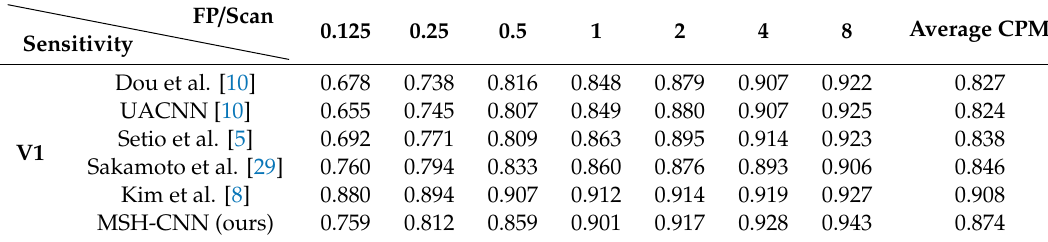
Table 3. Competitive performance metric (CPM) scores of di ff erent methods on V1 dataset of LUNA16. neural network.